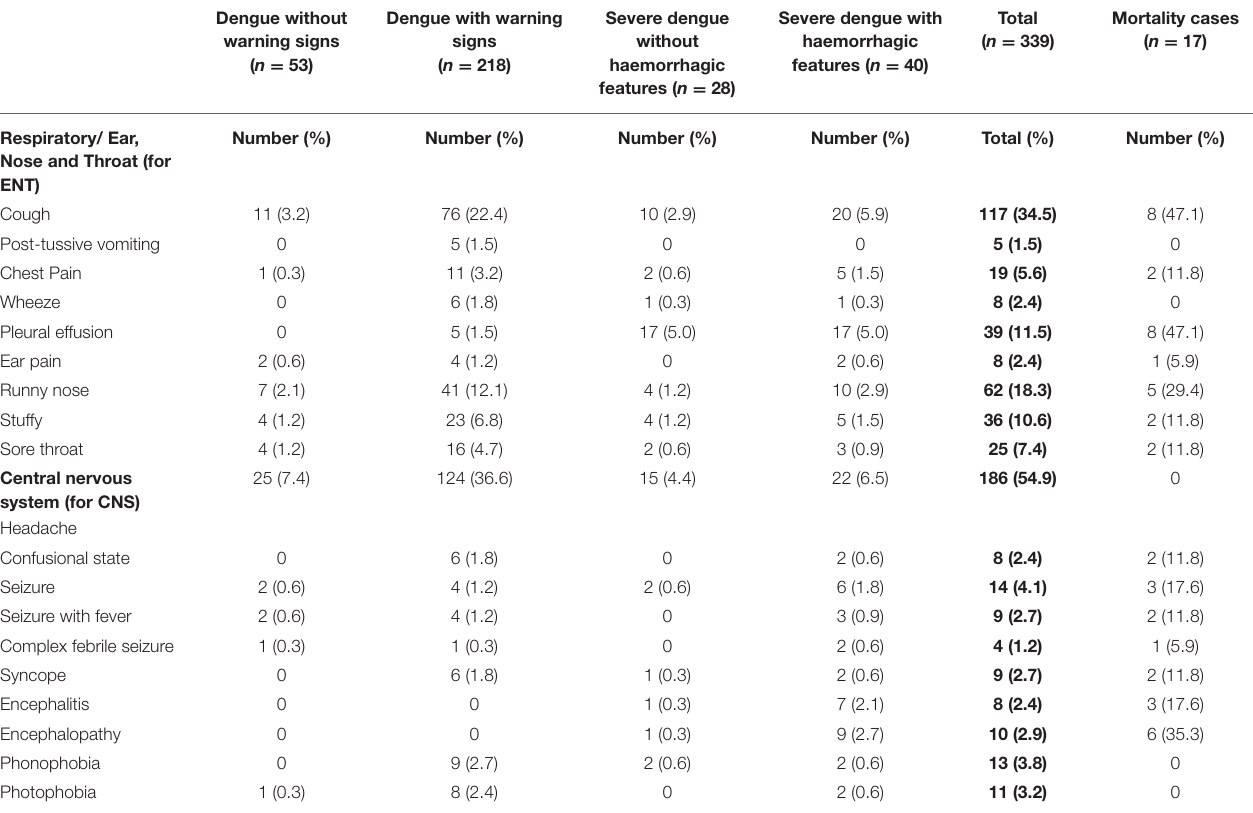
TABLE 3C | Clinical manifestations in pediatric patients hospitalized with suspected and confirmed dengue in the 2018–2019 epidemic. Dengue without Dengue with warning warning signs signs